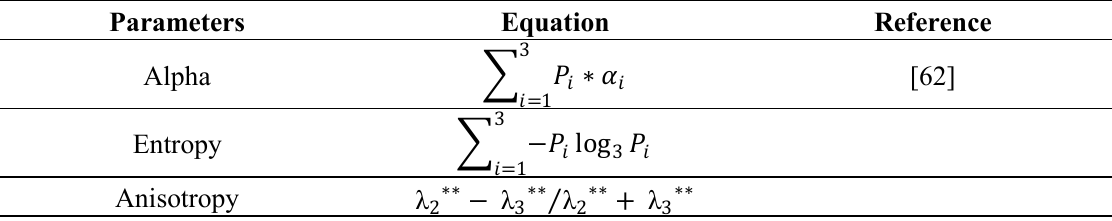
Table 4. Alpha—Entropy decomposition parameters.